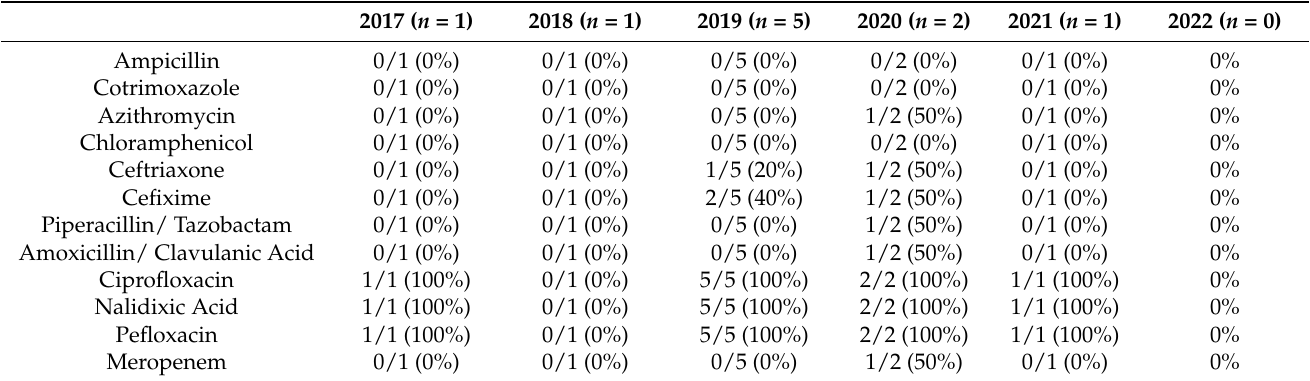
Table 6. Percentages (%) of antibiotic resistance that were found in the Salmonella Paratyphi A isolates against different antibiotics across 5 years